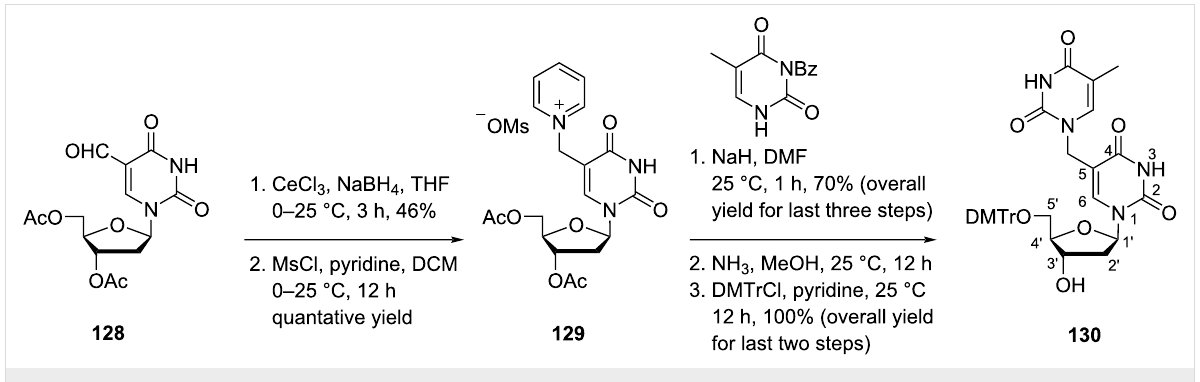
Scheme 32: Synthesis of double-headed nucleoside 130